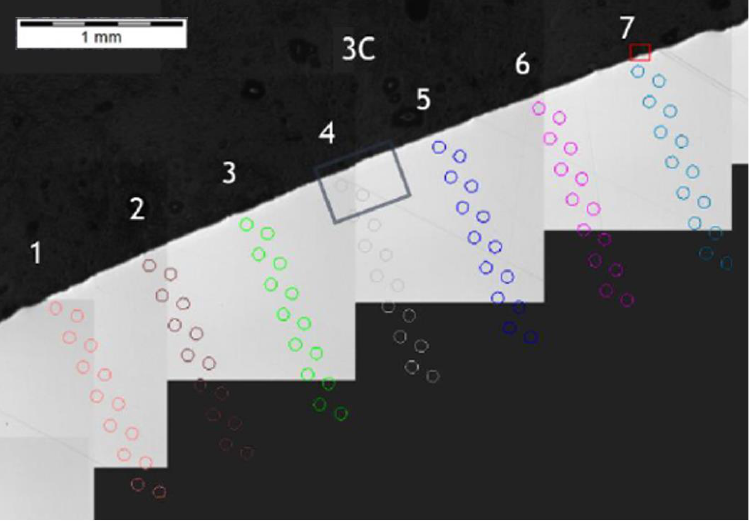
Figure 16. Pattern of hardness verification. Cross-section G1-G1, zone: 3C.